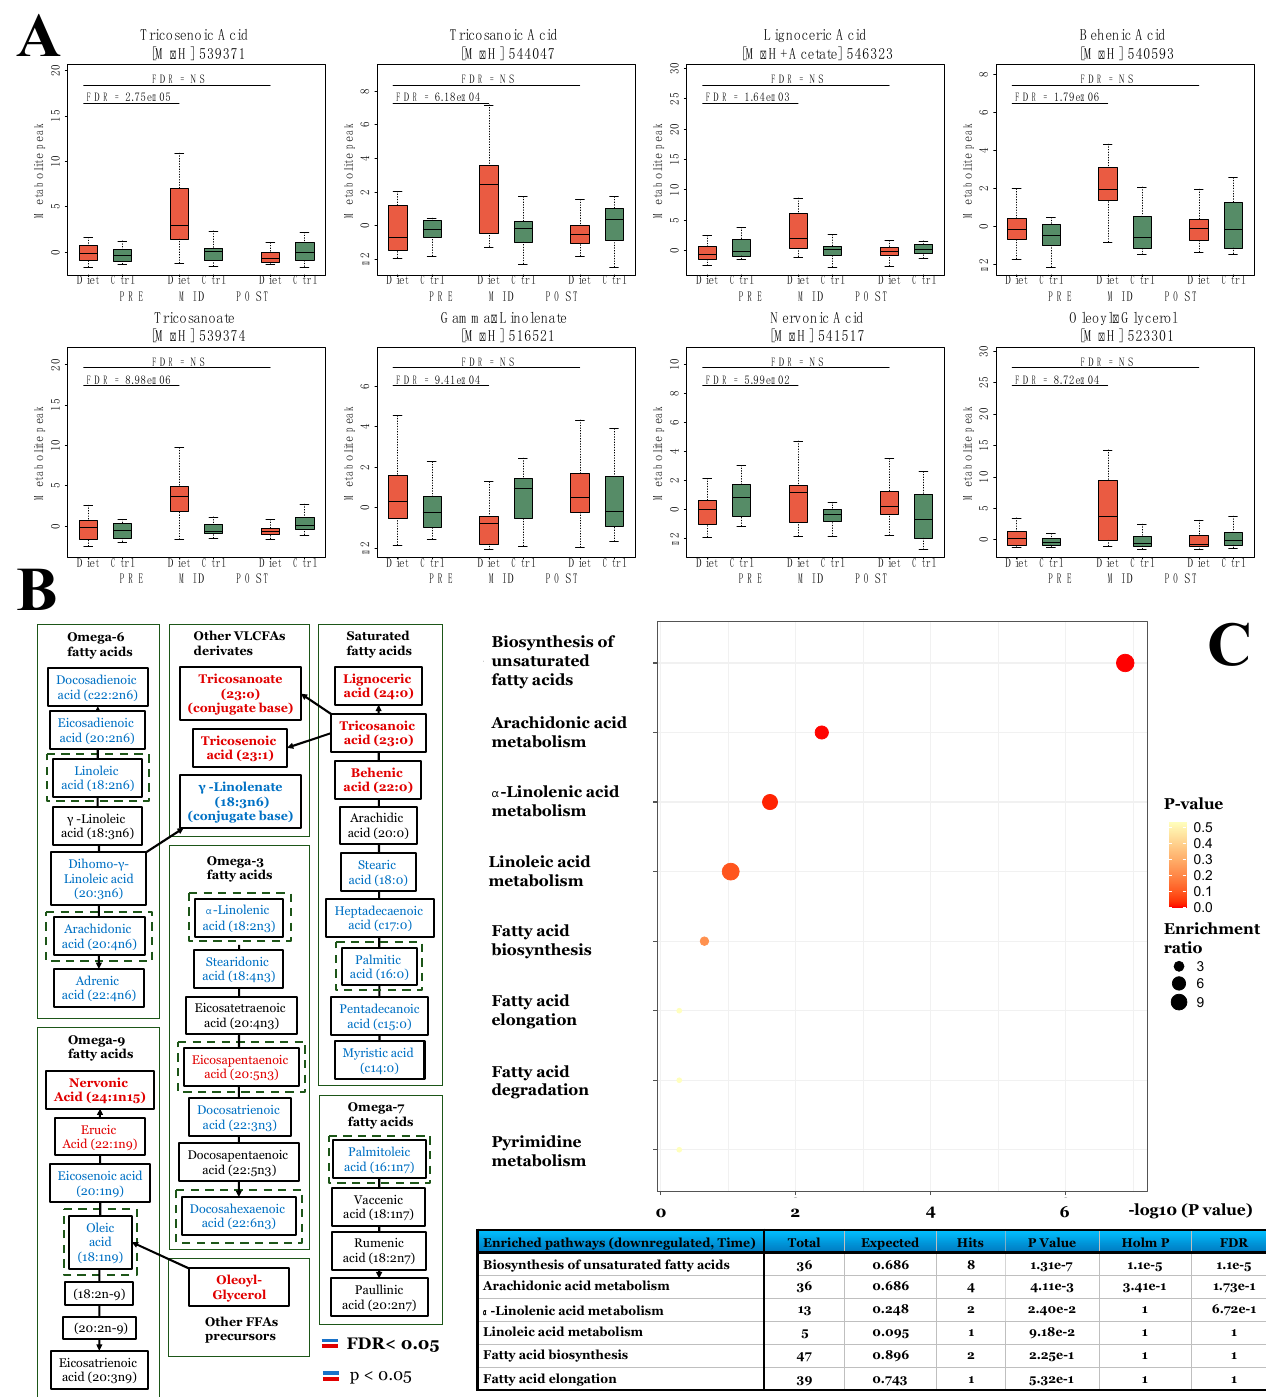
Figure 4. Substantial fat mass loss to low levels promotes accumulation of very-long-chain free fatty acids (VLCFA). Here, we demonstrate how the prolonged period of low-energy availability and high volume of exercise training leading to substantial fat mass loss (PRE-MID in diet group) modulated plasma fatty acid profile. First, FFAs and their metabolites, namely VLCFAs, that were significant in the diet group when compared to controls (Time × Group, FDR < 0.05) are depicted in panel ( A ). Following, fatty acid metabolism pathways related to ω -3, -6, -7, -9, and saturated fatty acids and associated reactions are depicted in panel B. Within unsaturated and saturated fatty acid metabolism pathways panel ( B ), upregulated (FDR < 0.05, red) metabolites are indicated with red color, downregulated (FDR < 0.05, blue) metabolites with blue color, and metabolites with no clear change in metabolite level with black color (PRE-MID). Bold text indicates significance in the